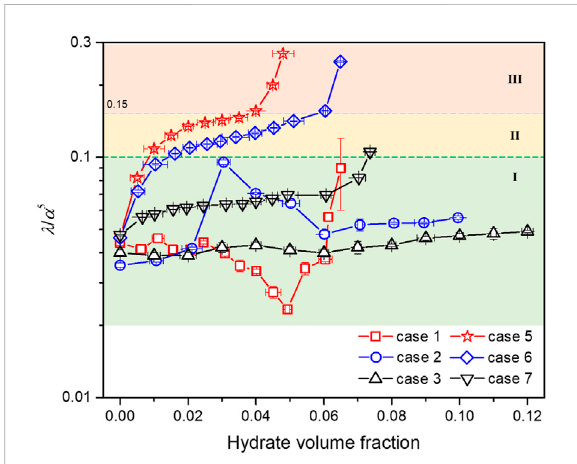
FIGURE 7 Variation trend of the dimensionless parameter λ / α 5 versus hydrate volume fraction. The vertical axis is in log-scale. Regions marked by I, II, and III in different colors represent low, medium, and high plugging risks,